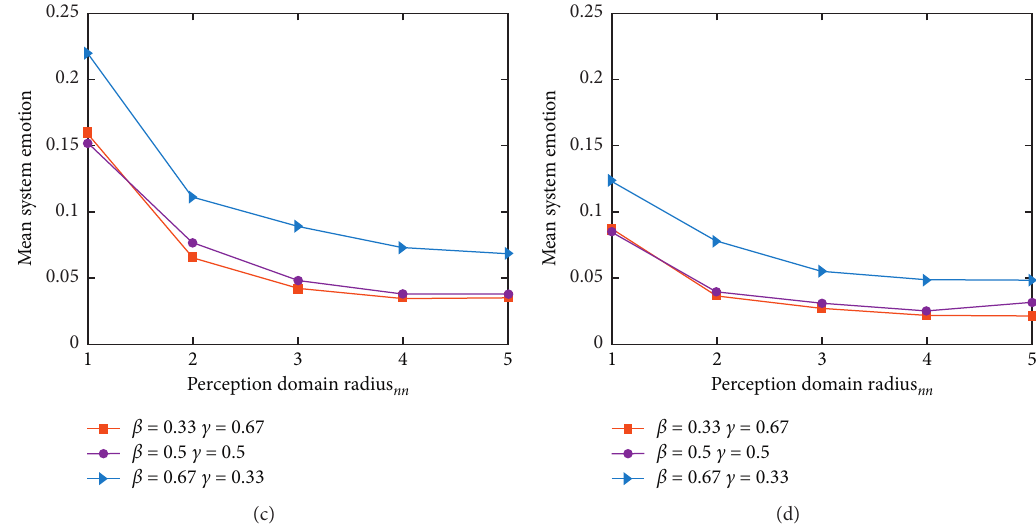
Figure 17: Mean system emotion value under different initial conditions and different perception domain radius. (a) λ � 0 . 4. (c) λ � 0 . 6. (d) λ � 0 . (b) λ emotion emotion emotion